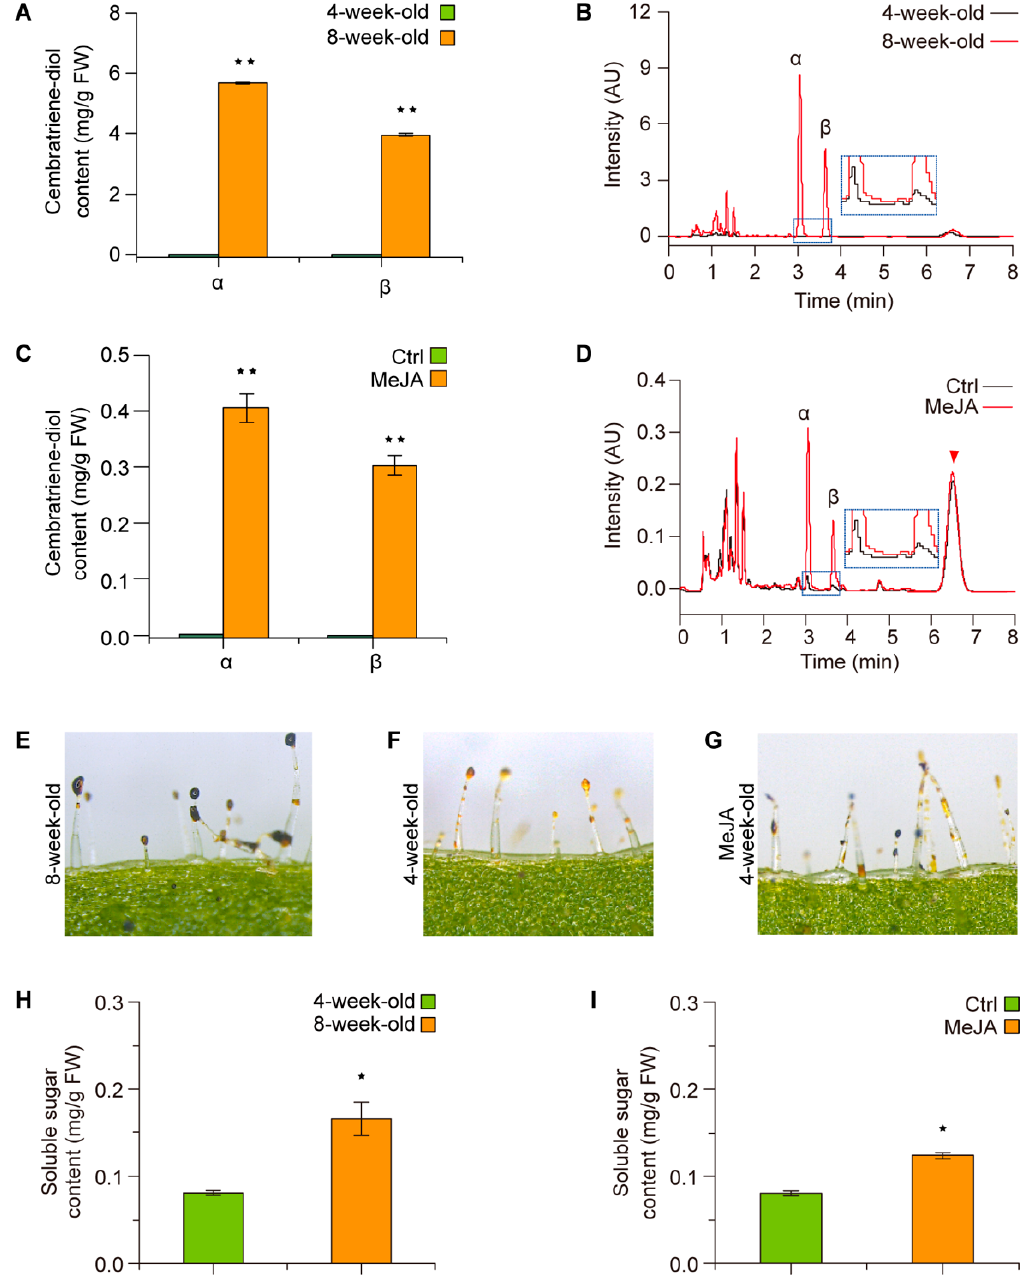
Figure 2. JA treatment improved the production of cembratriene-diol in tobacco. ( A ) Comparison of cembratriene-diol content between the four-week-old and eight-week-old tobacco plants. ( B ) The representative chromatogram profiles of cembratriene-diol determination by the UPLC system for the four-week-old and eight-week-old plants. ( C ) Determination of cembratriene-diol content between the control (Ctrl) and MeJA-treated four-week-old tobacco plants. ( D ) The representative chromatogram profiles of cembratriene-diol determination by the UPLC system for the control and MeJA-treated four-week-old plants. The triangle indicates an unidentified compound. ( E – G ) Trichome secretion droplets stained by I 2 /KI. ( H , I ) Soluble sugar content of the trichome secretion droplets. Values in ( A , C , H , I ) are the average of the data from three plants with triplicate measurements. Asterisks in ( A , C , H , I ) indicate significant difference from the four-week-old plants or the control treatment. Insets in ( B , D ) show the enlargements of the chromatogram images in the blue rectangles, and α and β in the graphs of ( B , D ) indicate α -cembratriene-diol and β -cembratriene-diol, respectively. Error bars, mean ± SE.